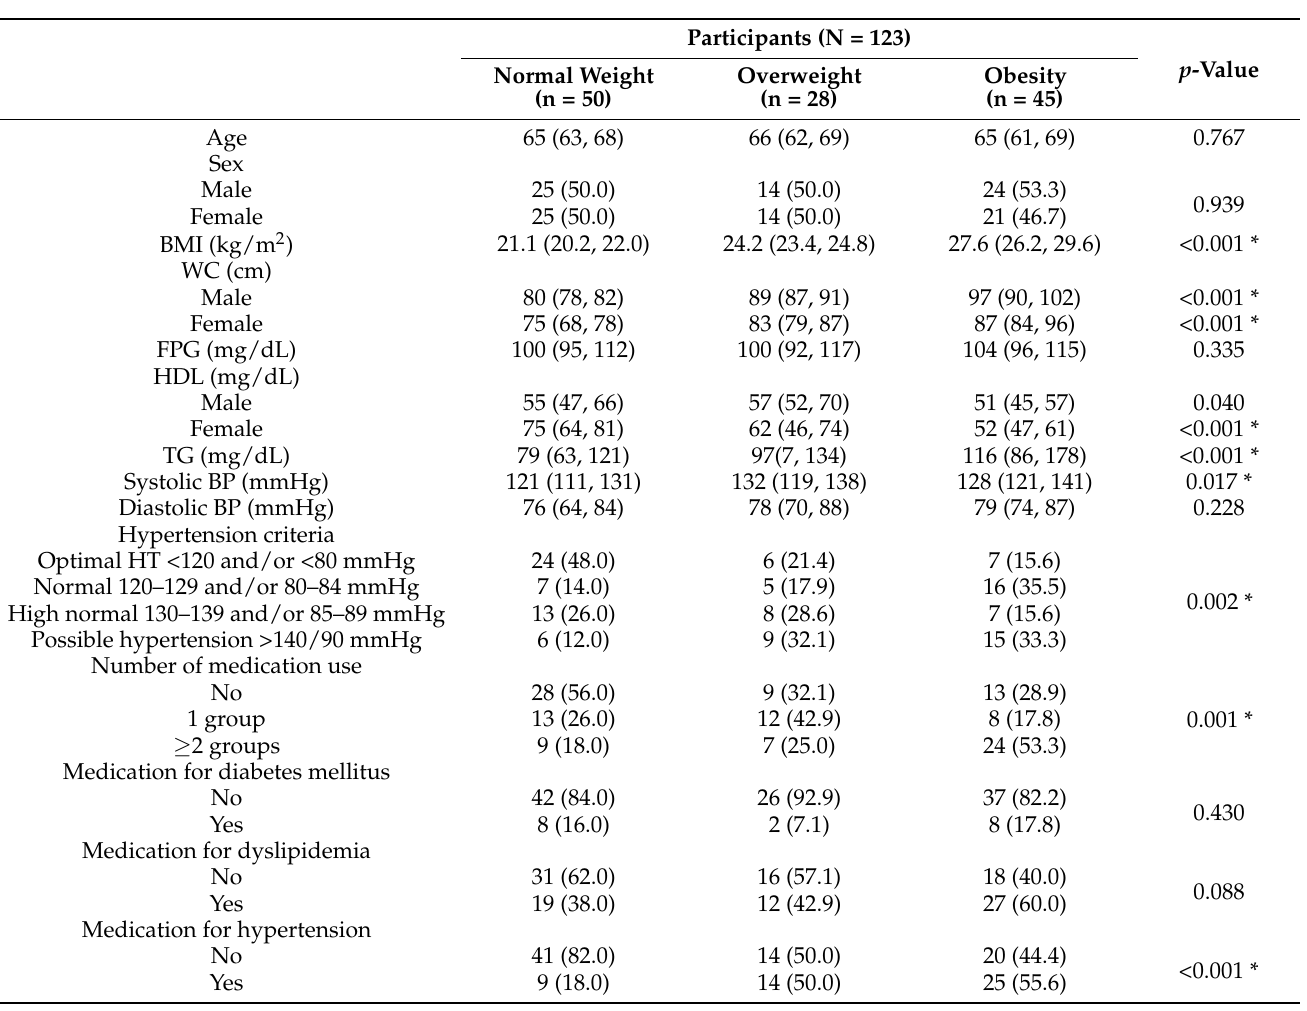
Table 1. Characteristics of participants according to body mass index (BMI) (n (%) or median (first, third